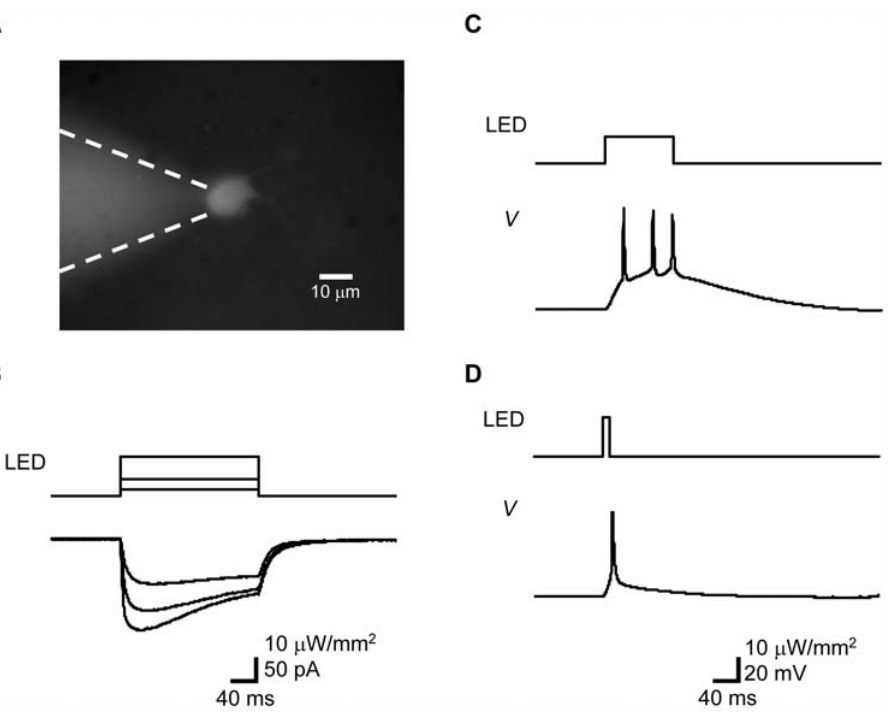
Figure 3. Direct photoactivation of ChR2V-expressing RGCs. (A) The blue light-emitting diode (LED)-evoked membrane currents and potentials were recorded under whole-cell recording from one of the ChR2V-expressing RGCs. (B) The photocurrents and their dependency in the LED power density. (C–D) The membrane potential responses of a ChR2V-expressing RGC to LED pulses of 100-ms (C) or 10-ms (D) duration.